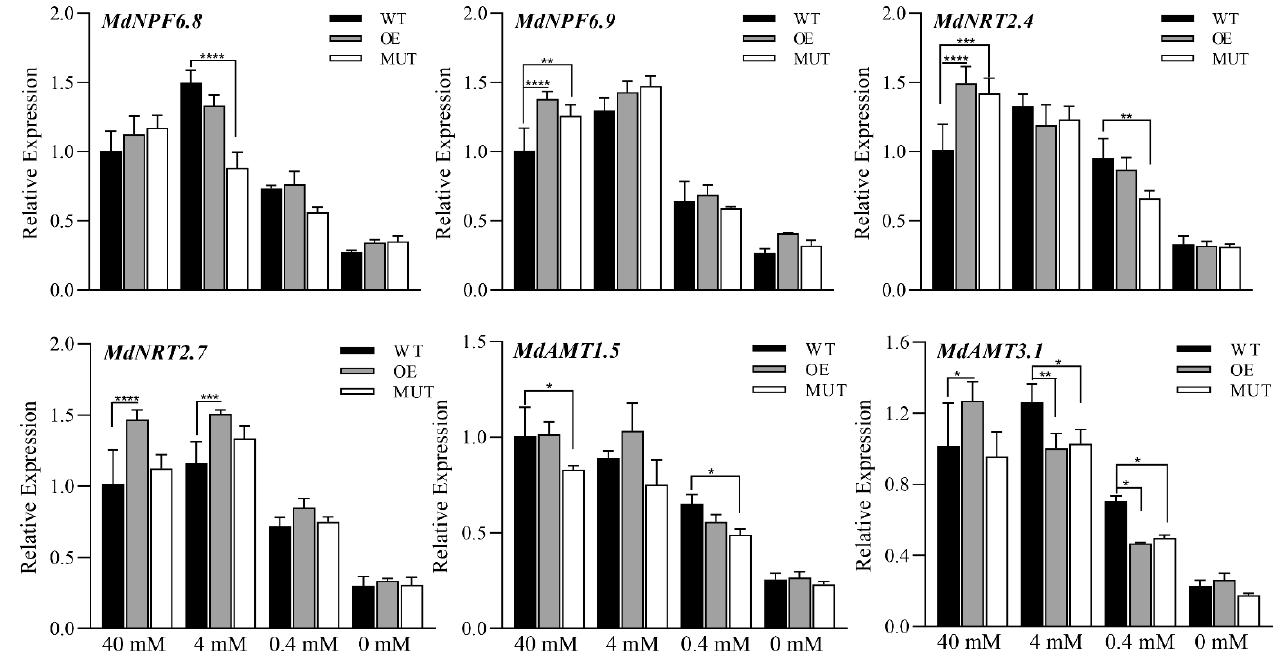
Figure 9. Expression levels of nitrogen regulatory genes in the calli of wild-type (WT) plants, transformed CRISPR/Cas9- MdMKK9 (MUT) lines, and transformed pRI101- MdMKK9 (OE) lines grown in mediums with different nitrogen concentrations. The relative level of nitrogen transport-related genes in 40 mM NO 3 − treated WT calli was set to 1. The bars represent means ± SD ( n = 3). Asterisks indicate statistically significant differences (* p < 0.05; ** p < 0.01; *** p < 0.001; **** p < 0.0001).